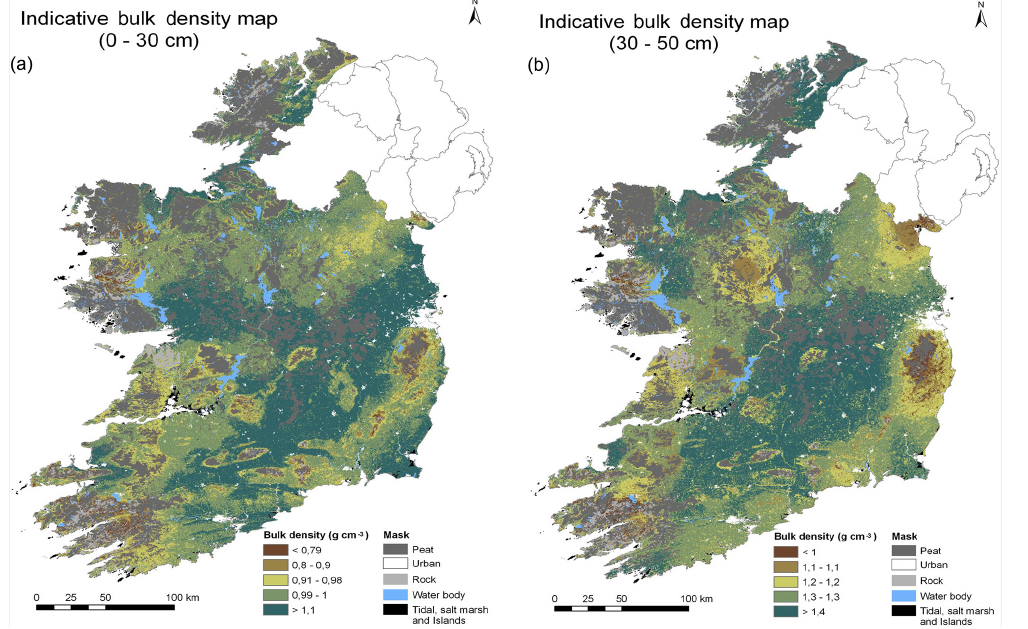
Figure 4. (a) Indicative soil bulk density distribution map for Ireland (0–30cm, gcm − 3 ). (b) Indicative soil bulk density distribution map (30–50cm, gcm − 3